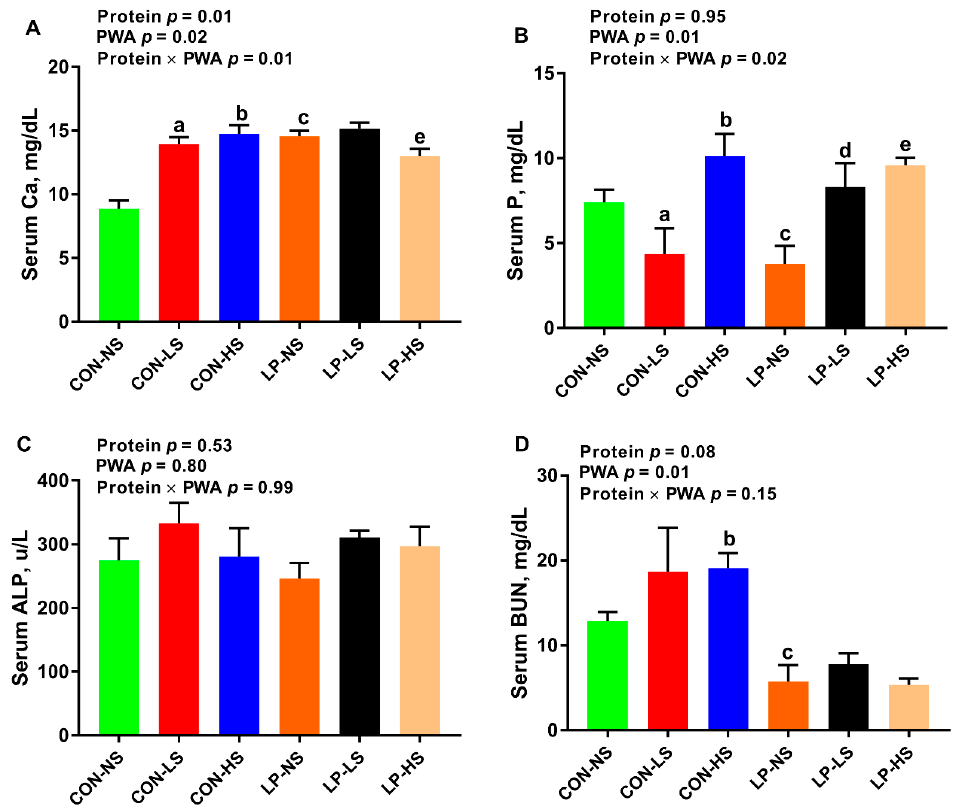
Figure 2. Serum ( A ) calcium (Ca), ( B ) phosphorus (P), ( C ) alkaline phosphatase (ALP) and ( D ) blood urea nitrogen (BUN) of nursery pigs fed with two levels of dietary protein and three levels of a phytogenic water additive (PWA). CON-NS: control diet with no PWA supplemented, CON-LS: control diet with a low dose of PWA (4 mL/L of water) supplemented, CON-HS: control diet with a high dose of PWA (8 mL/L of water) supplemented, LP-NS: low-protein diet with no PWA added, LP-LS: low-protein diet with a low dose of PWA (4 mL/L of water) added and LP-HS: low-protein diet with a high dose of PWA (8 mL/L of water) added. a p ≤ 0.05 CON-NS vs. CON-LS, b p ≤ 0.05 CON-NS vs. CON-HS, c p ≤ 0.05 CON-NS vs. LP-NS, d p ≤ 0.05 LP-NS vs. LP-LS, and e p ≤ 0.05 LP-NS vs. LP-HS. Values are the means ± SEM. n = 7–8 for each dietary